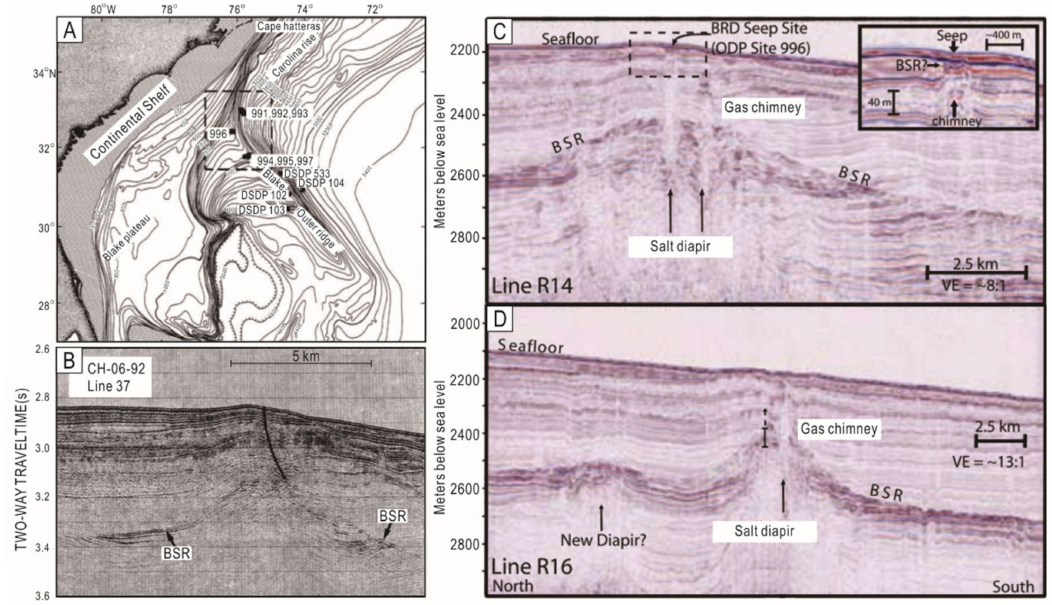
Figure 17. ( A ) Map of the continental margin of southeastern North America. Note the locations of the Blake Ridge, the Carolina Rise, and OPD Leg 164 sites (Sites 991–997). ( B ) Earlier seismic profile showing the doming of the BSR over Blake Ridge Diapir and a fault (heavy solid line) that extends to the base of BSR. ( C ) Seismic line R14 across Site 996. Note the upwarping of the BSR around the diapir, disruption of the BSR by chimneys, and seeps on the seafloor. The dashed box represents the location of the inset showing the upper chimney and BSR near the seafloor. ( D ) Seismic line R16. A chimney disturbs the BSR and extends to the seafloor. ( A is cited from [99]; B is cited from [100]; C and D are modified from